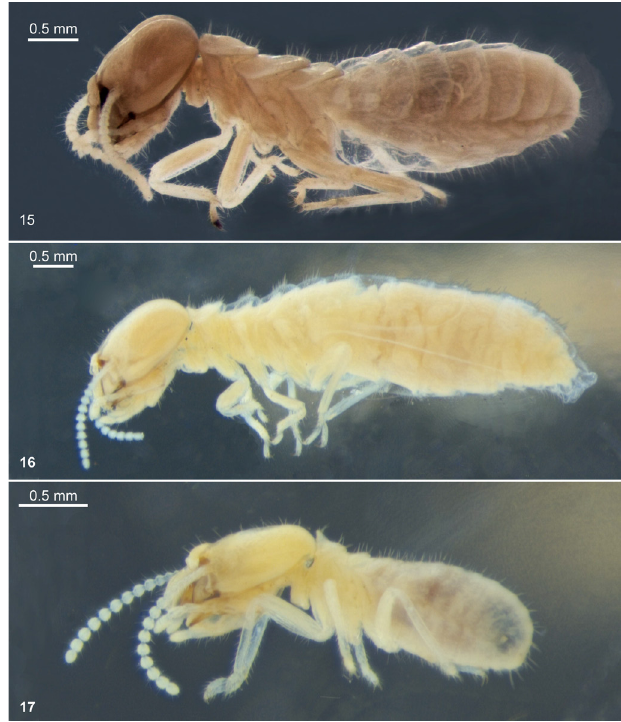
Figs 15–17. 15- Prorhinotermes simplex, pseudergate in profile ; 16- Coptotermes gestroi , pseudergate in profile and 17- Dolichorhinotermes latilabrum , worker in